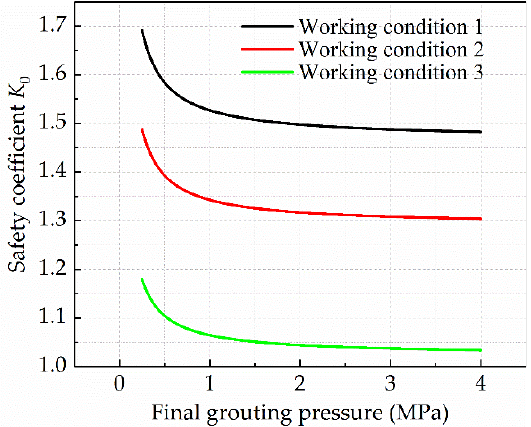
Figure 9. Relationship between final grouting pressure and safety coefficient.